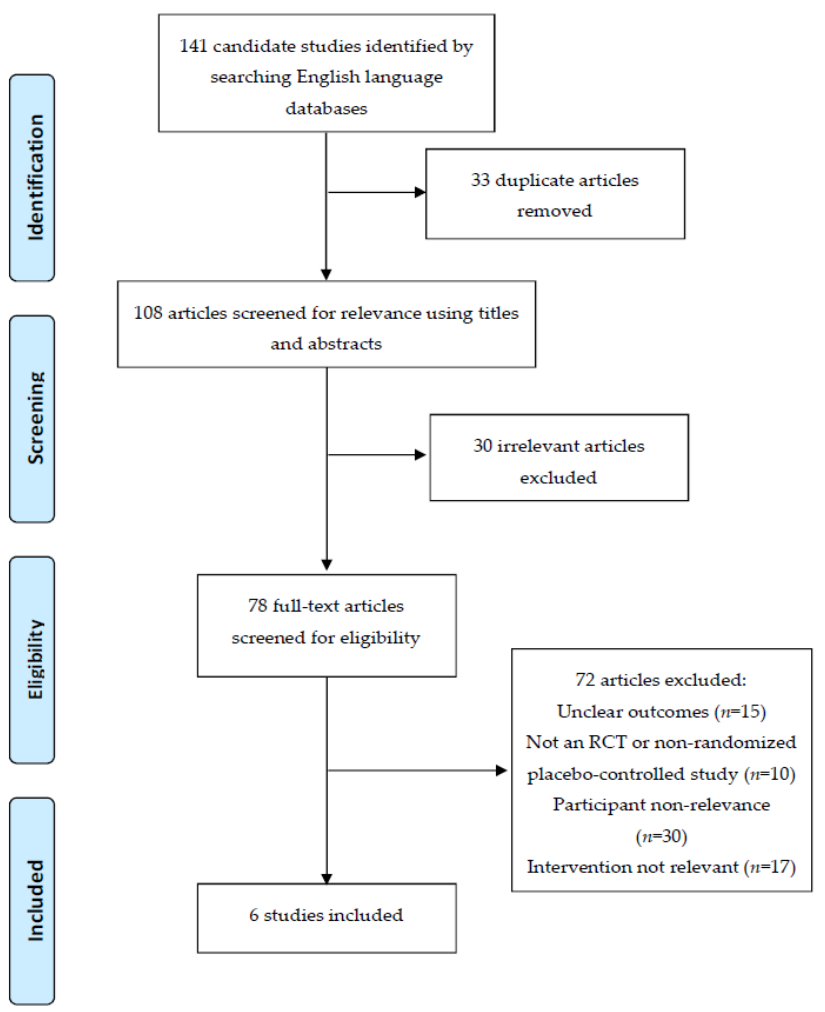
Figure 1. PRISMA (Preferred Reporting Items for Systematic Reviews and Meta-Analysis) flowchart detailing the disposition of screened, included, and excluded records.